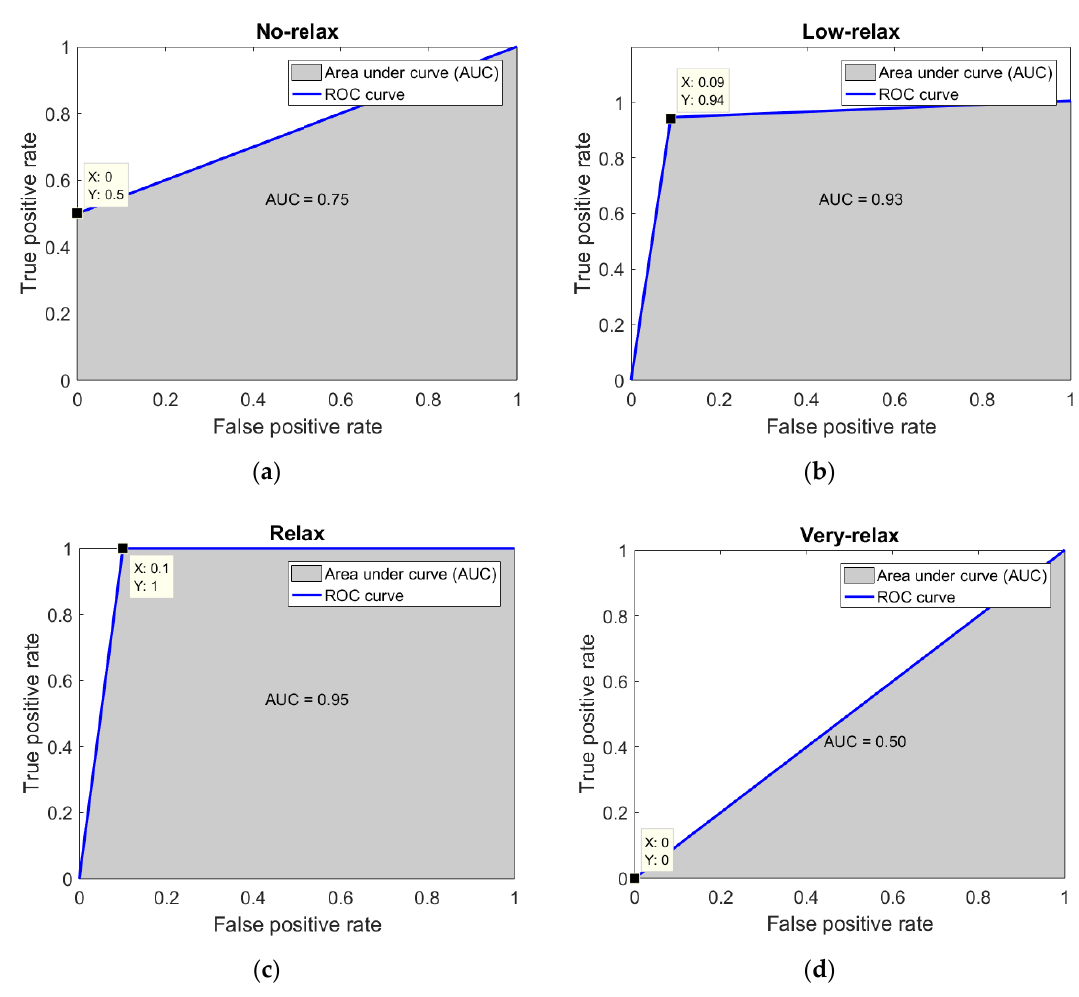
Figure 15. Receiver operating characteristic (ROC) curves of classifier activity: ( a ) no-relax; ( b ) low-relax; ( c ) relax; ( d ) very-relax.